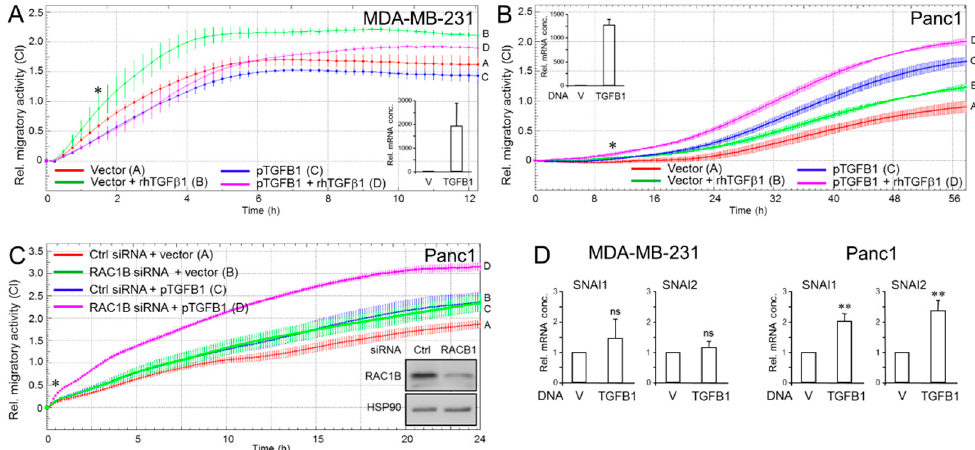
Figure 3. Effect of ectopic overexpression of TGFB1 in MDA-MB-231 and Panc1 cells on cell motility. ( A ) MDA-MB-231 cells were transfected with either empty vector or an expression vector encoding TGF β 1 (pTGFB1) and 48 h later subjected to real-time measurement of random cell migration in the absence or presence of rhTGF β 1 (5 ng/mL). Differences between the green curve (tracing B) and the magenta curve (tracing D) were first significant at 1:30 ( ∗ ) and all later time points. ( B ) As in (A), except that Panc1 cells ectopically overexpressing TGF β 1 cells were assayed. Differences between the green curve (tracing B) and the magenta curve (tracing D) were first significant at 10:24 ( ∗ ) and all later time points. Overexpression of transfected TGF β 1 in ( A , B ) was validated by qPCR analysis (insets), and by ELISA with culture supernatants from pTGFB1 transfected cells with or without the addition of rhTGF β 1 (Figure S3). ( C ) Panc1 cells were transiently cotransfected with Ctrl siRNA or RAC1B siRNA along with either empty vector or pTGFB1. Then, 48 h later the transfectants were analyzed on the xCELLigence platform for changes in migratory activities. Differences between the green curve (tracing B) and the magenta curve (tracing D) were first significant at 1:00 ( ∗ ) and all later time points. Successful knockdown of RAC1B was verified by immunoblotting with HSP90 as loading control (inset). Data in ( A – C ) are the mean ± SD from 3 or 4 parallel wells. ( D ) QPCR analysis SNAI1 and SNAI2 in MDA-MB-231 and Panc1 cells (mean ± SD, n = 3). V, empty vector; TGFB1, TGF β 1 expression vector. Ns, not significant. *, p < 0.05; **, p <